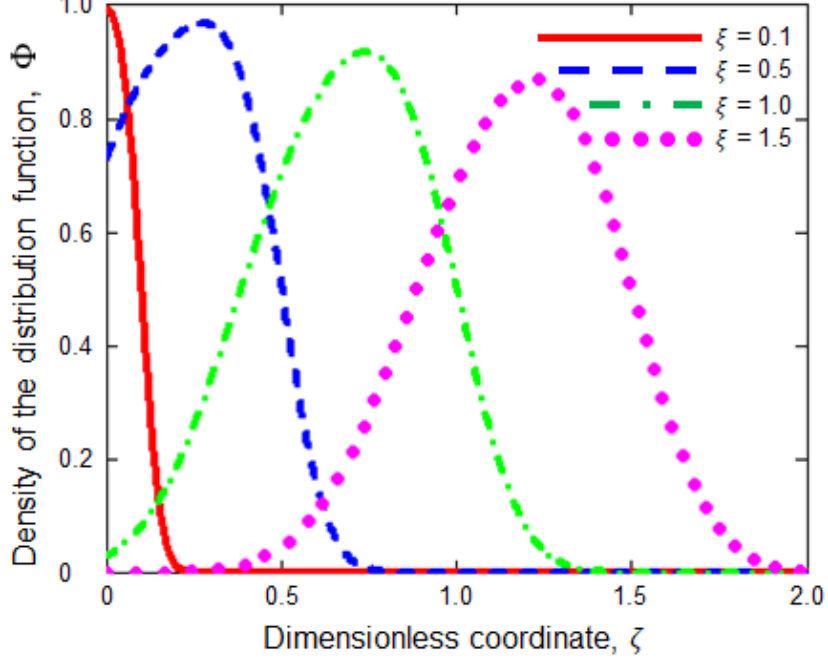
Figure 5. The dimensionless density of the distribution function Φ as a function of the crystal radius at different time moments.